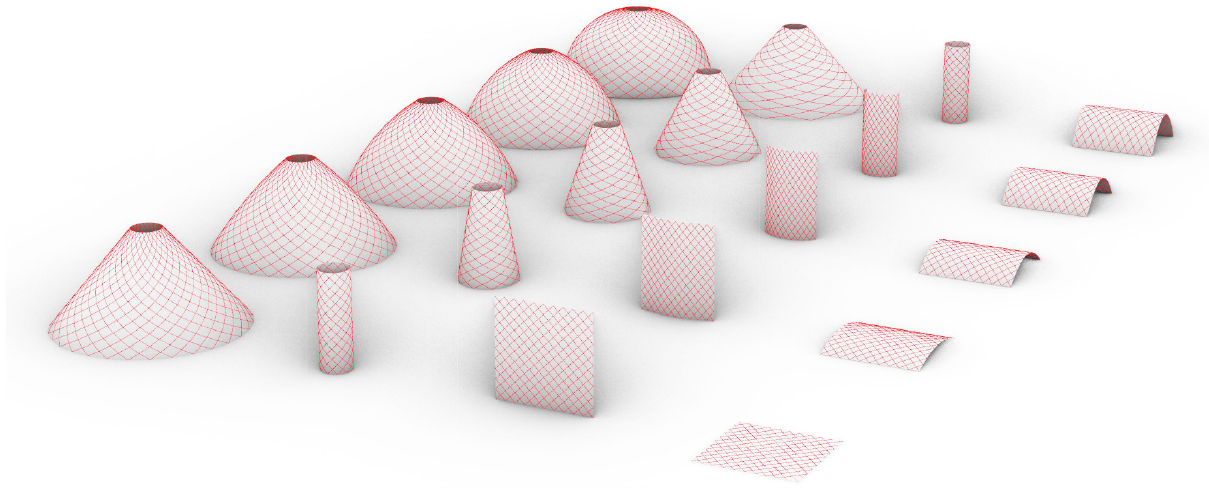
Figure 7: Different geometries and relative loxodromic